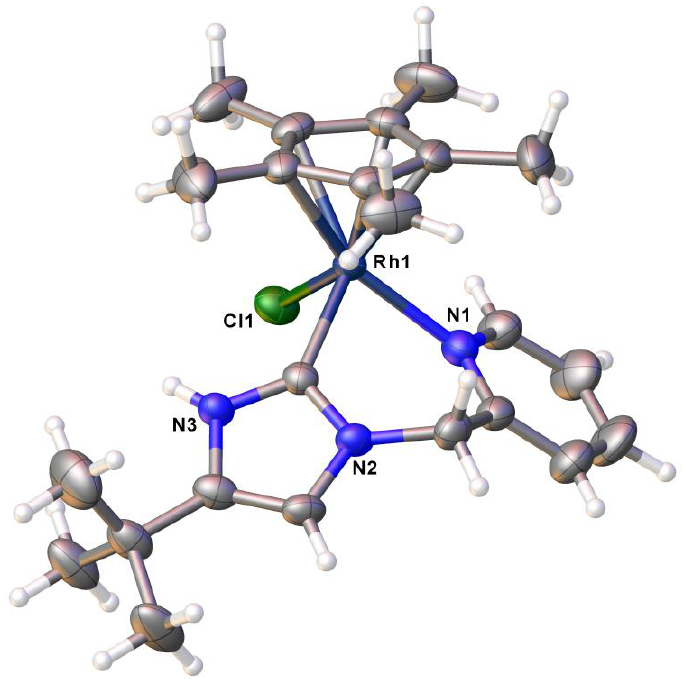
Figure 3. Crystal structure of the cation of 9b-Rh ; PF 6 − anion and two THF molecules are excluded for clarity.